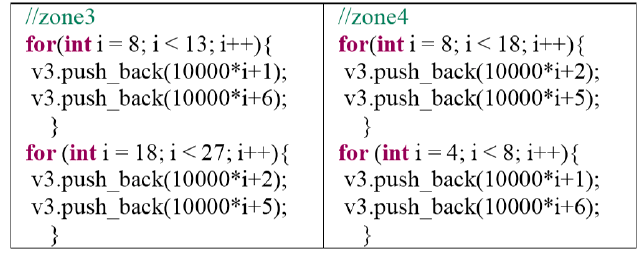
Figure 13. RP seat number generation.